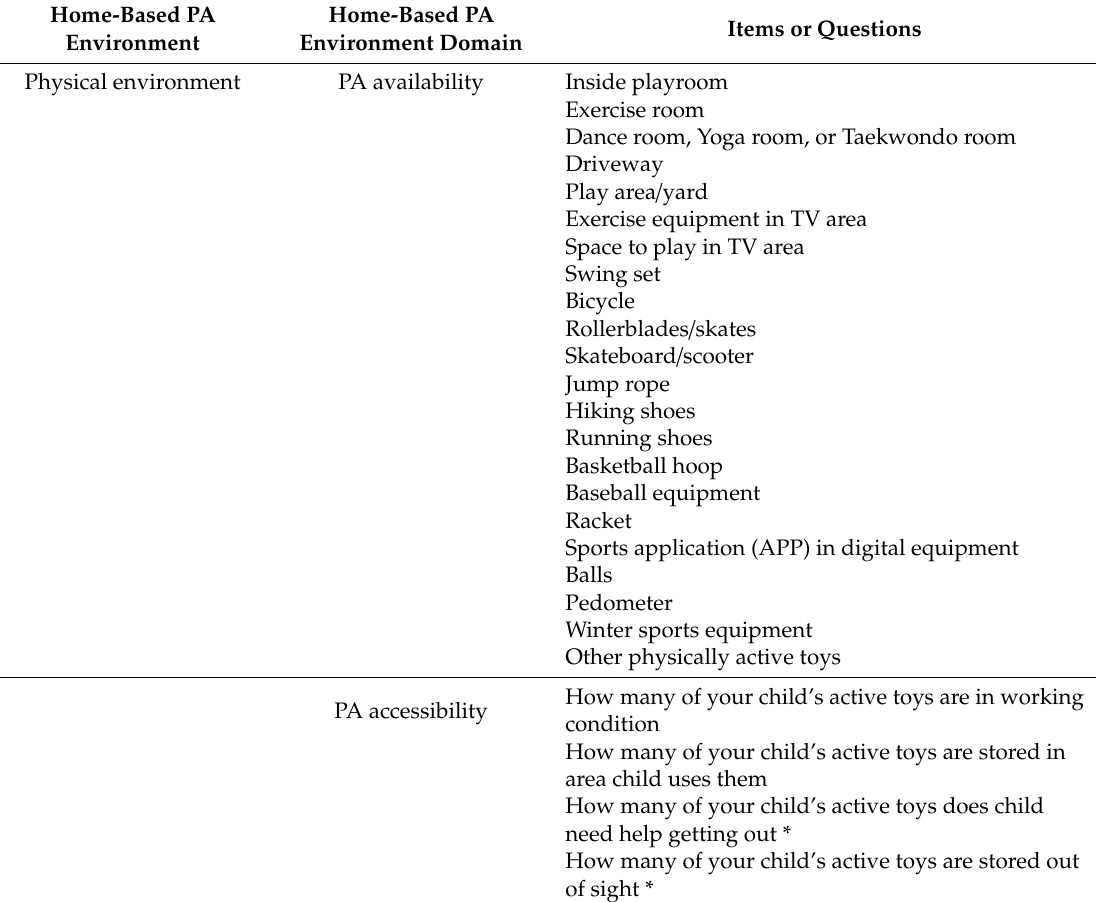
Table A1. The specific items of each home-based PA environment domain (based on Gattshall’s home-based PA environment questionnaire)